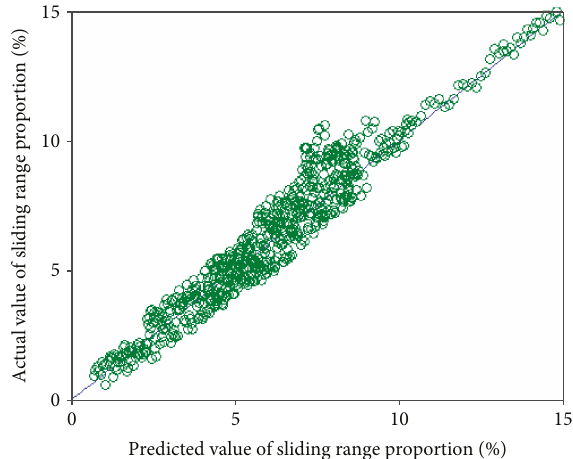
Figure 14: Scatter diagram of predicted values and actual values (acceleration and deceleration time proportion).